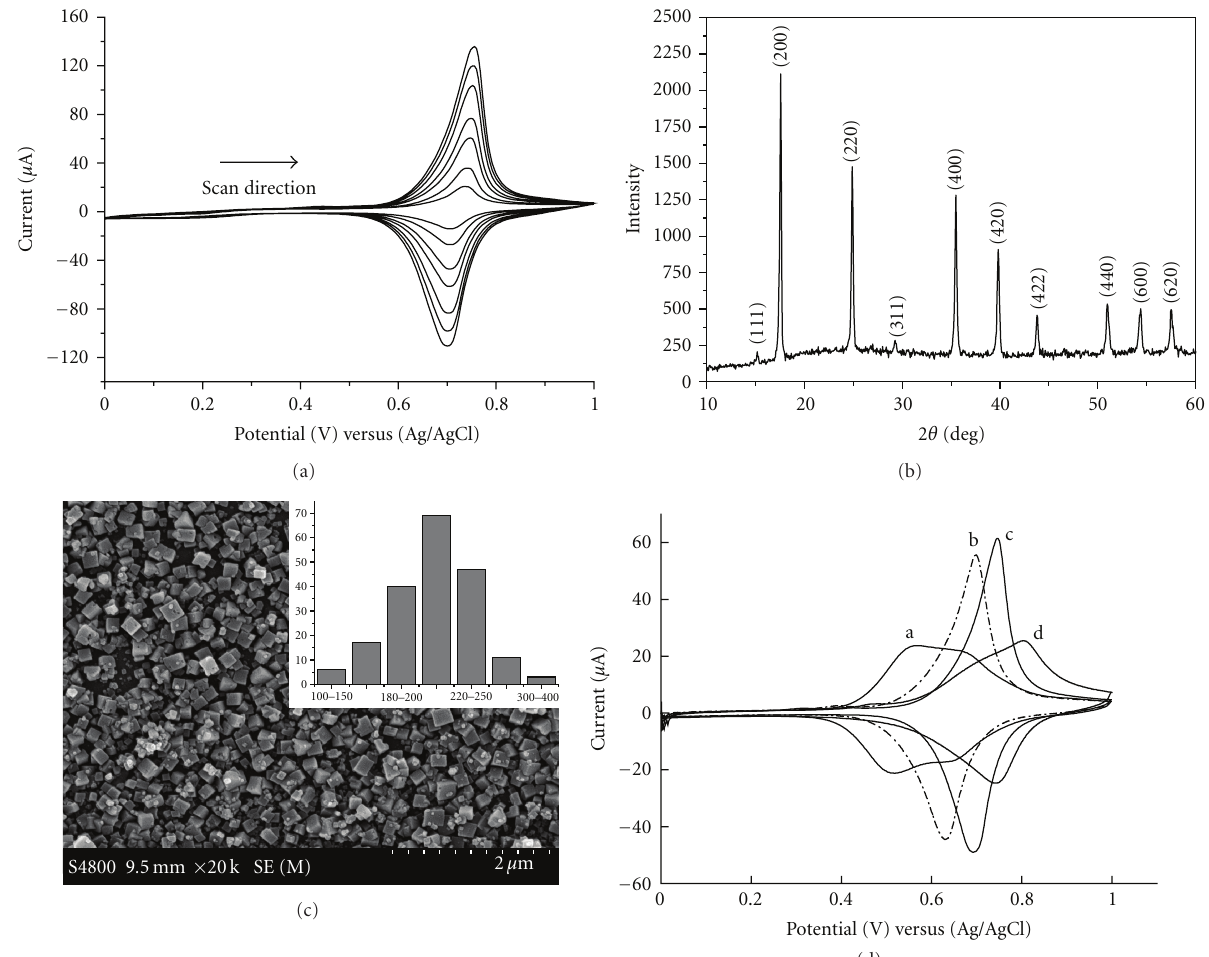
S4800 9 . 5mm × 20k SE (M)